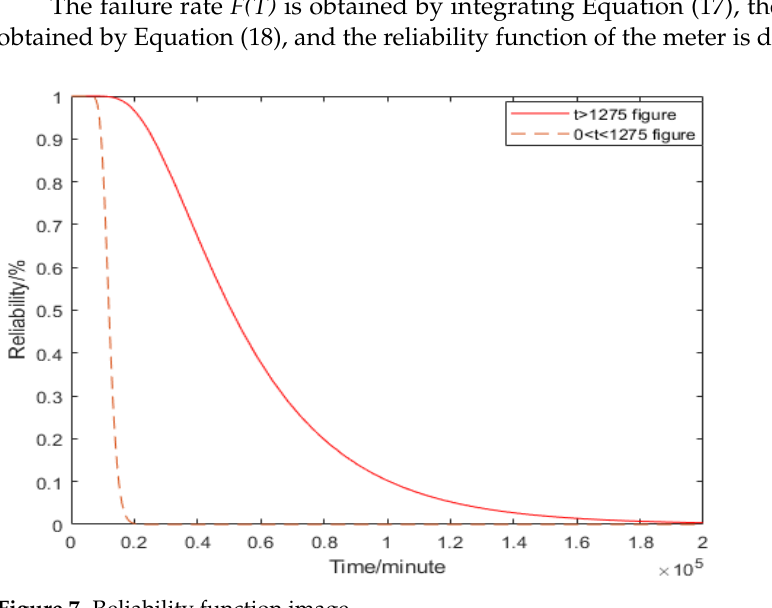
Figure 7. Reliability function image.